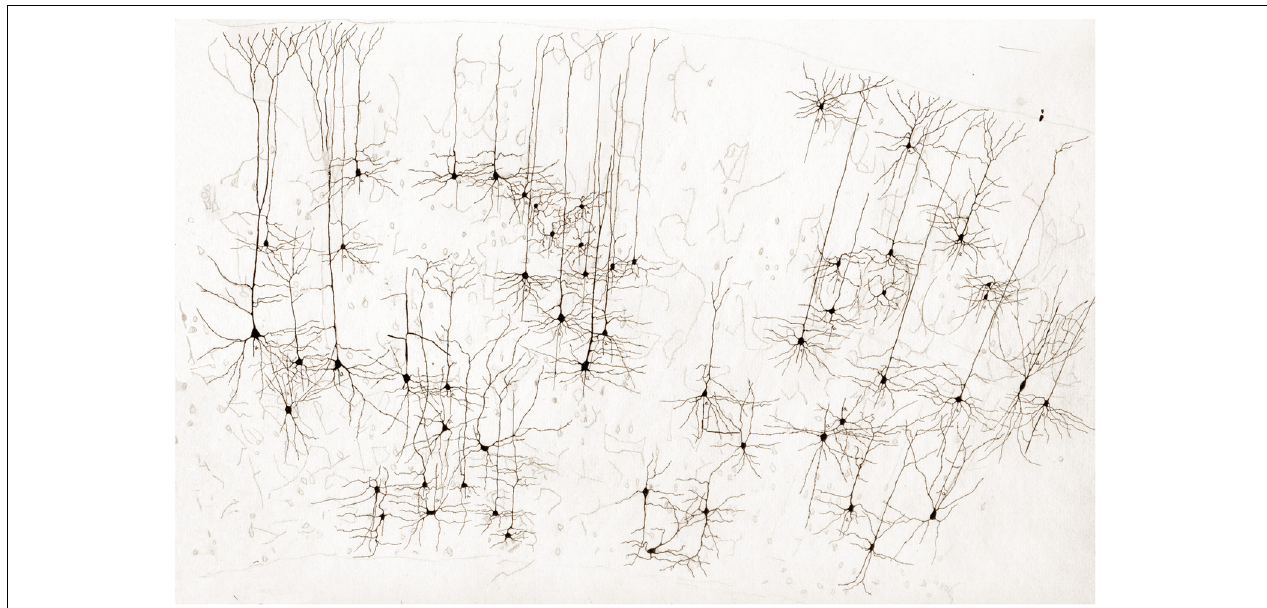
FIGURE 1 | Survey, unpublished drawing from the rat cerebral cortex by Lorente de Nó. Golgi-Cox